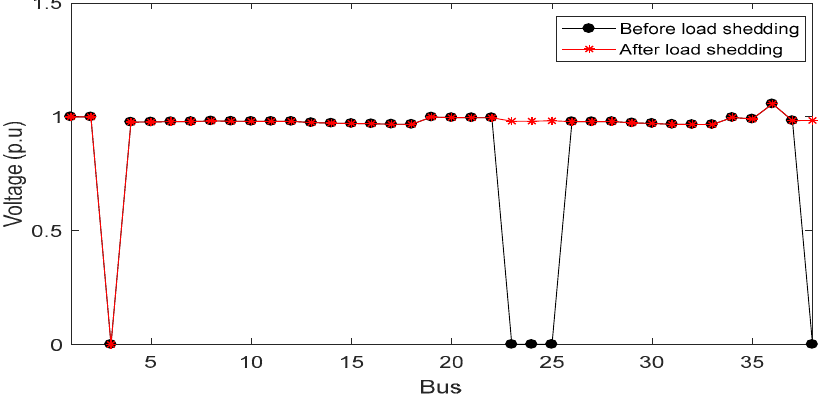
Figure 6. Bus voltages at faulted bus #3 before and after load shedding.